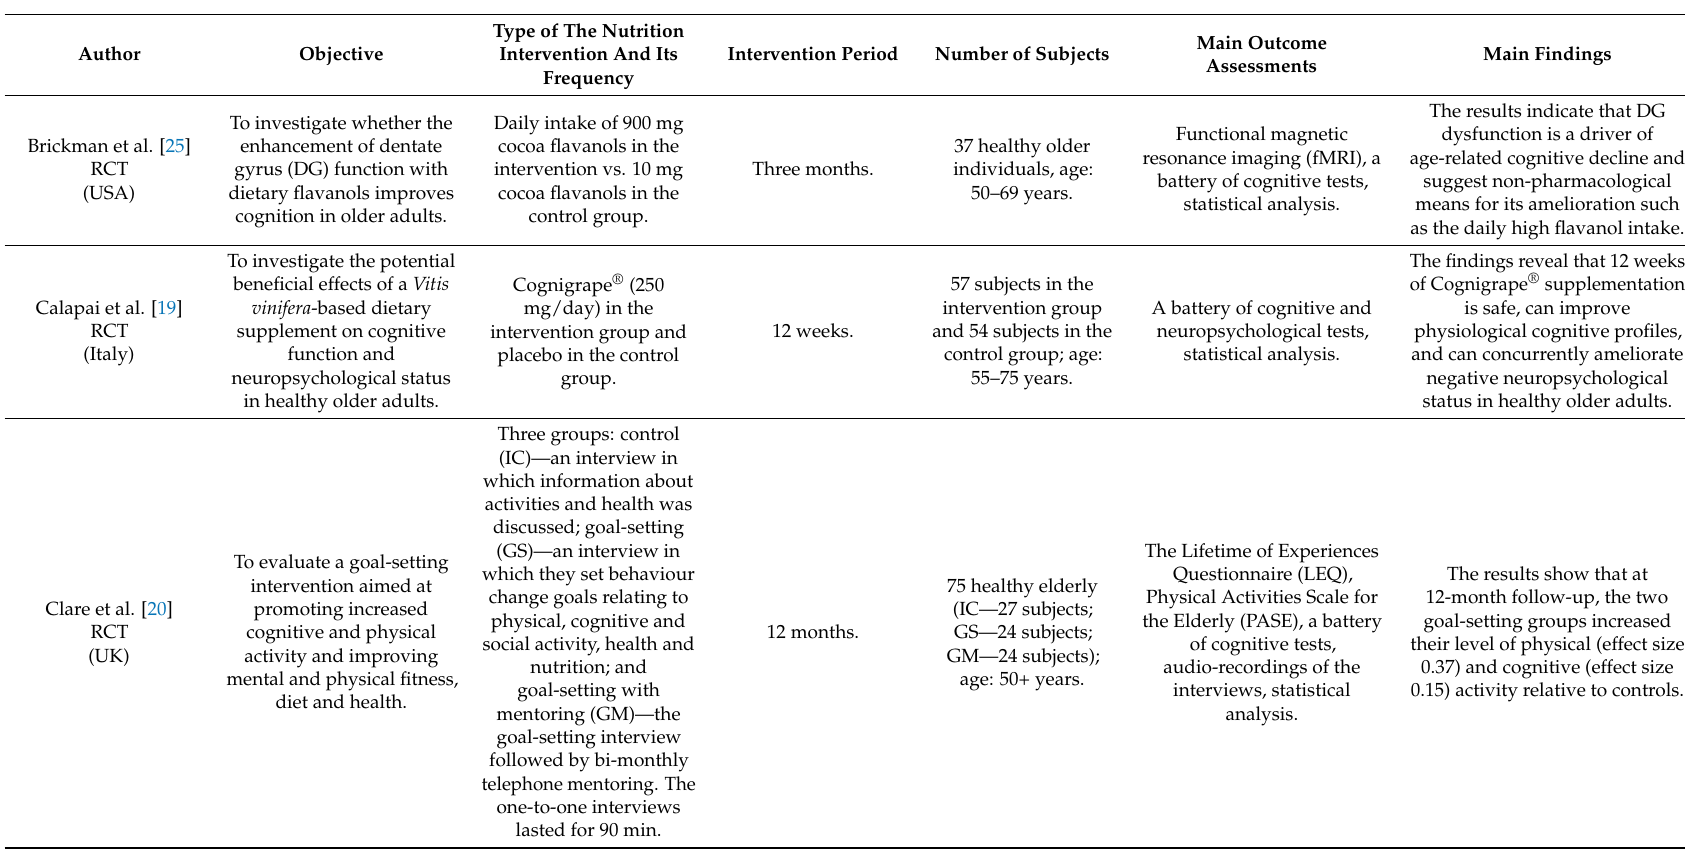
Table 1. Overview of the twelve selected studies focused on cognitive decline and its prevention by nutrition